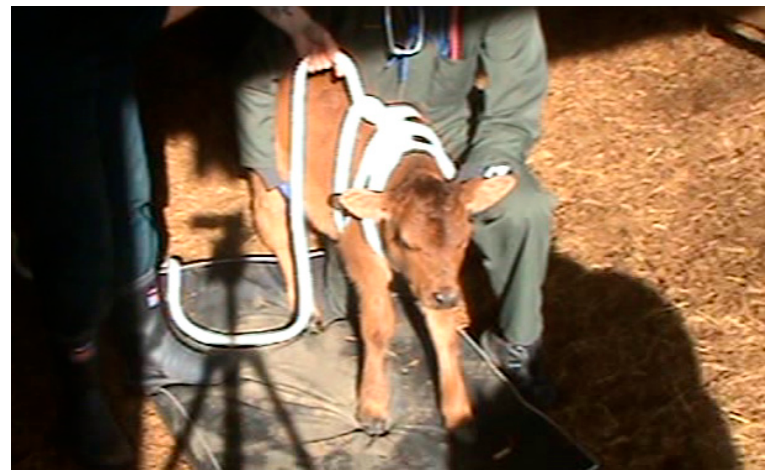
Figure 1. Rope squeeze placed around the thorax of a calf before pulling the rope tight.